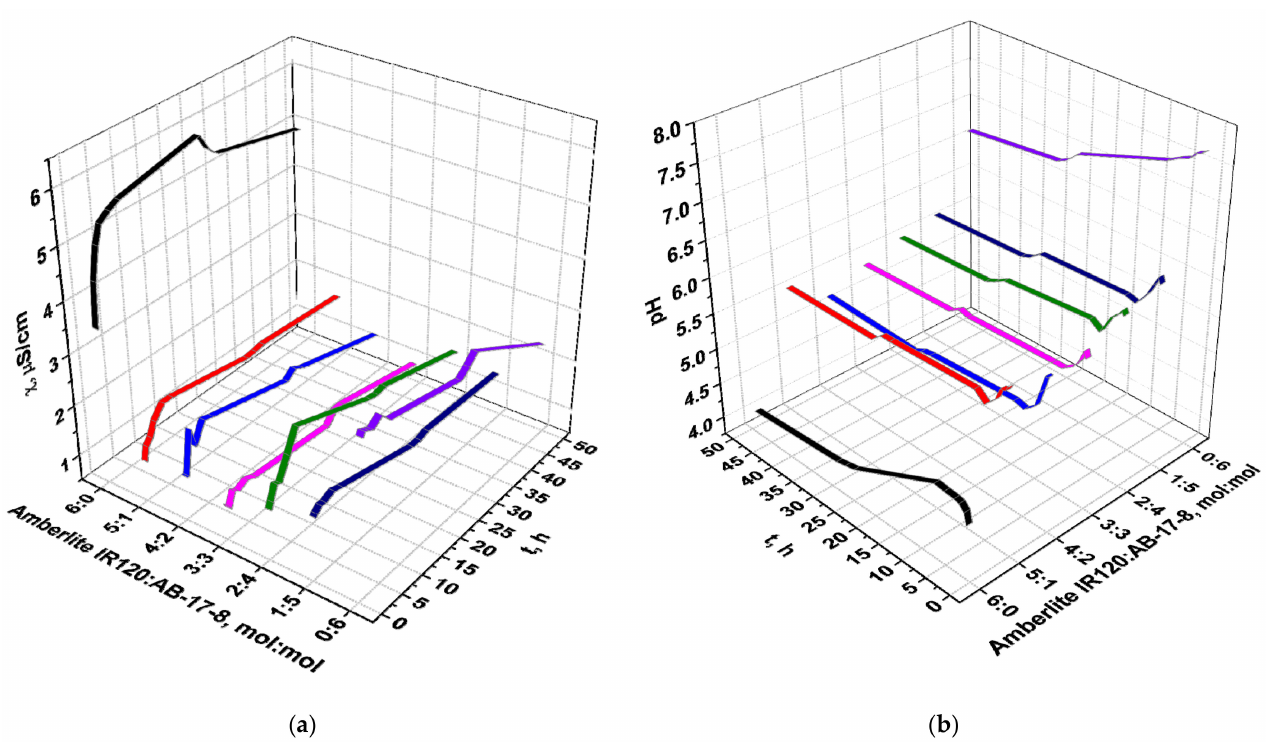
Figure 2. Specific electric conductivity ( a ) and pH ( b ) of the aqueous medium in the presence of the interpolymer system, Amberlite